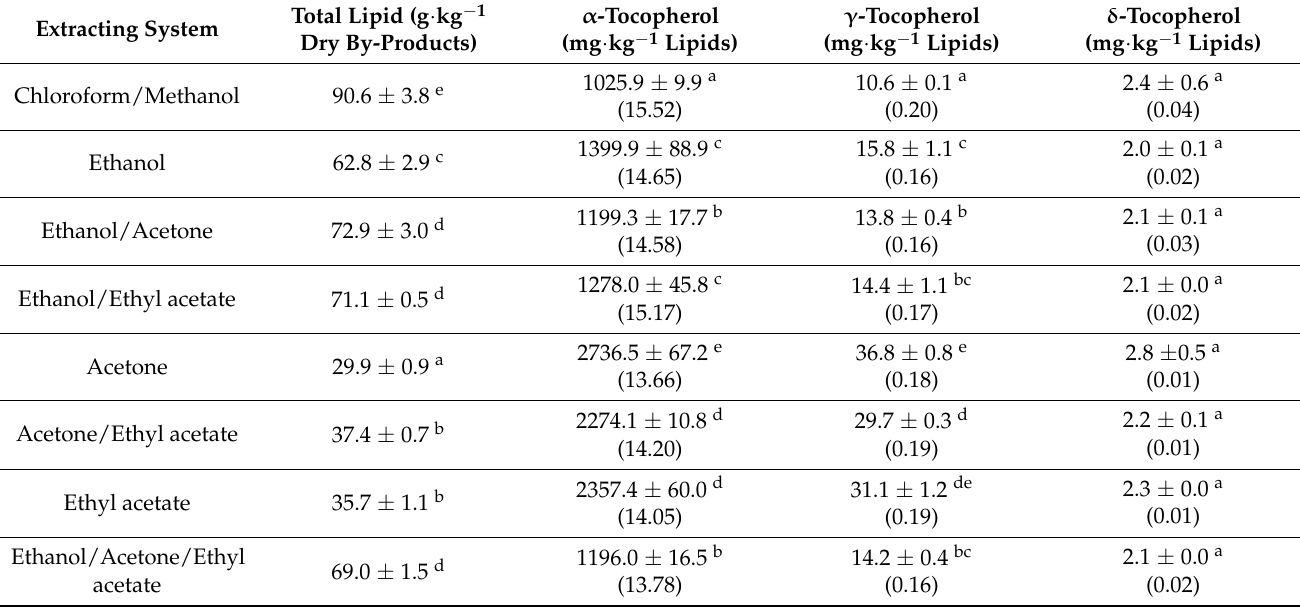
Table 2. Values * obtained for total lipid, α -tocopherol, γ -tocopherol, and δ -tocopherol in squid by-products by employing different lipid-extracting